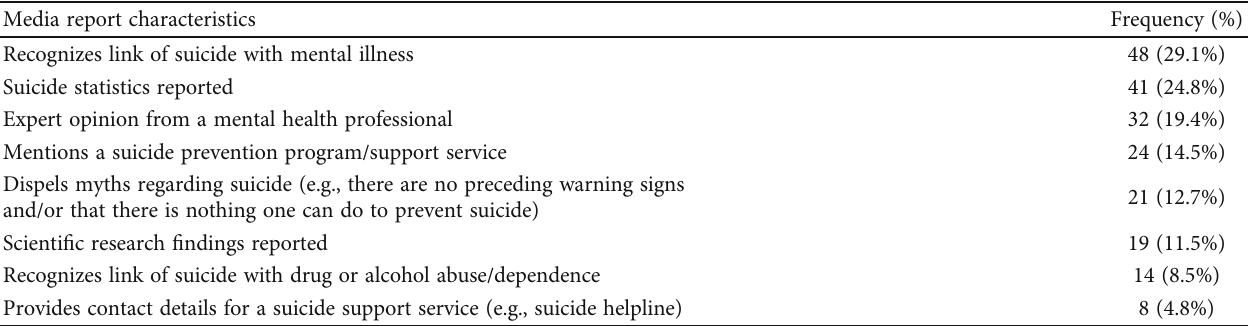
Table 2: Potentially helpful media reporting characteristics according to World Health Organization suicide reporting guidelines ( N = 165